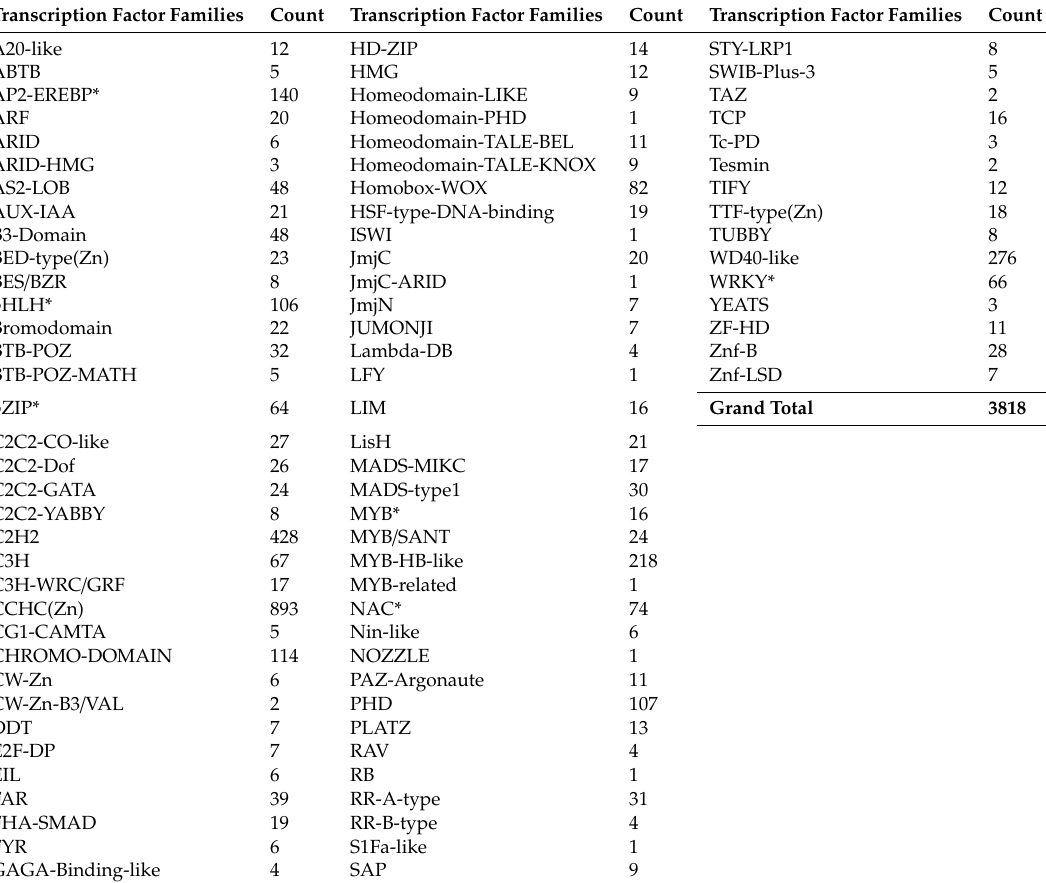
Table 1. Details of the hop transcription factor (TFs) families identified in this study. The TFs were identified using a combination of the plant TF database (https: // plantgrn.noble.org / PlantTFcat / ) and HMMER searches using the assembled transcriptome sequences of hop plants infected with Citrus bark cracking viroid